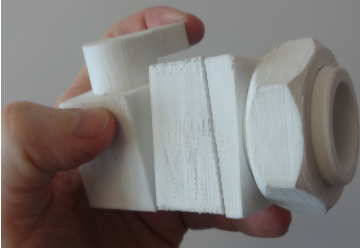
Figure 16. Upside-down delta 3-D printer with a stationary caulkstruder. Figure 17. Contoured 3-D printable spigot for a five gallon bucket.